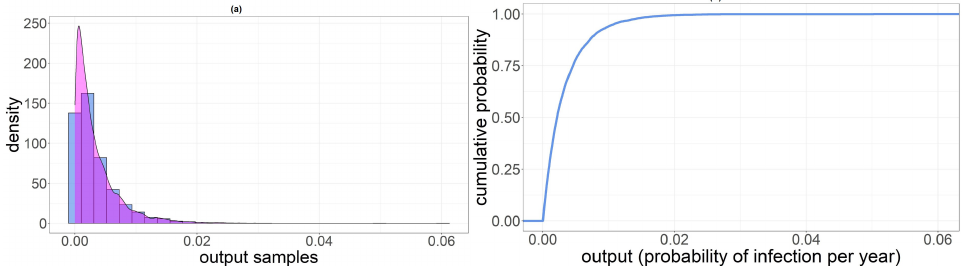
Figure 5. ( a ) Histogram of p SH samples. ( b ) Sample cumulative distribution of p SH